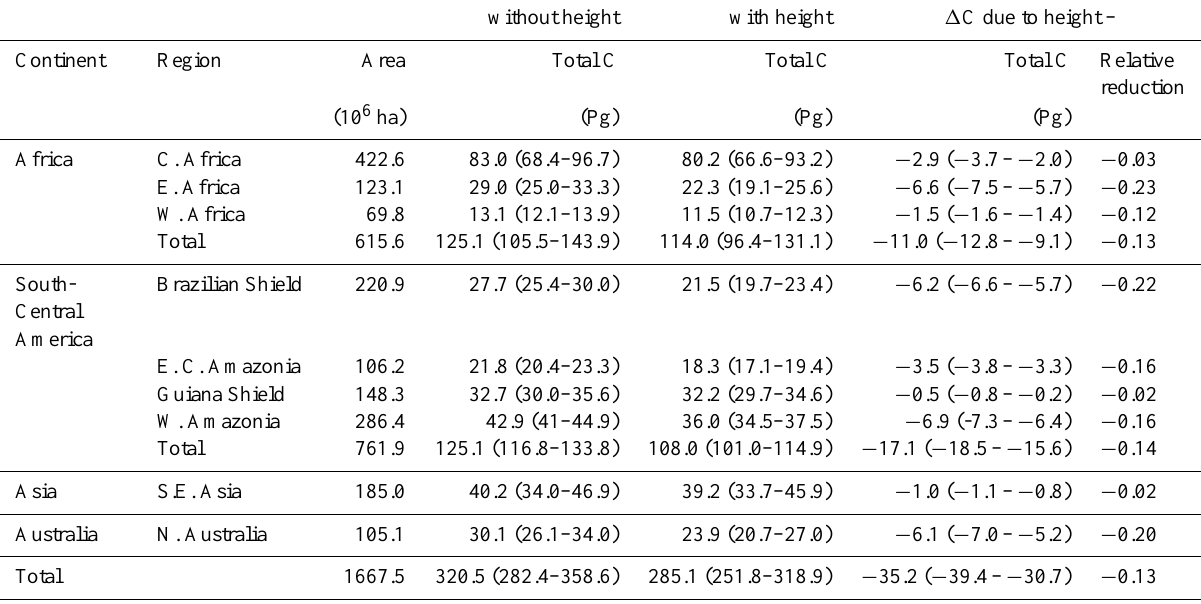
Table 5. Stocks and change in estimated pantropical C in aboveground live trees (mean and bootstrapped 95% CI) due to H integrated into biomass estimates based on region-specific estimates of tree H , compared to the pantropical forest biomass model that excludes H ∗